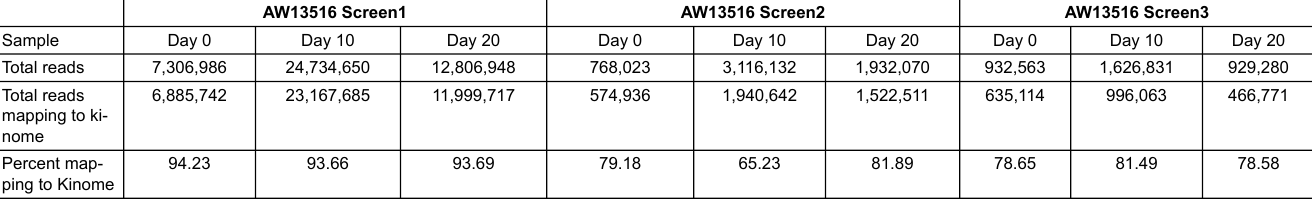
Table 1: QC data from sequencing showing the percentage of the reads mapping to the kinome library for all three samples for each of the three screens of the AW13516 cell